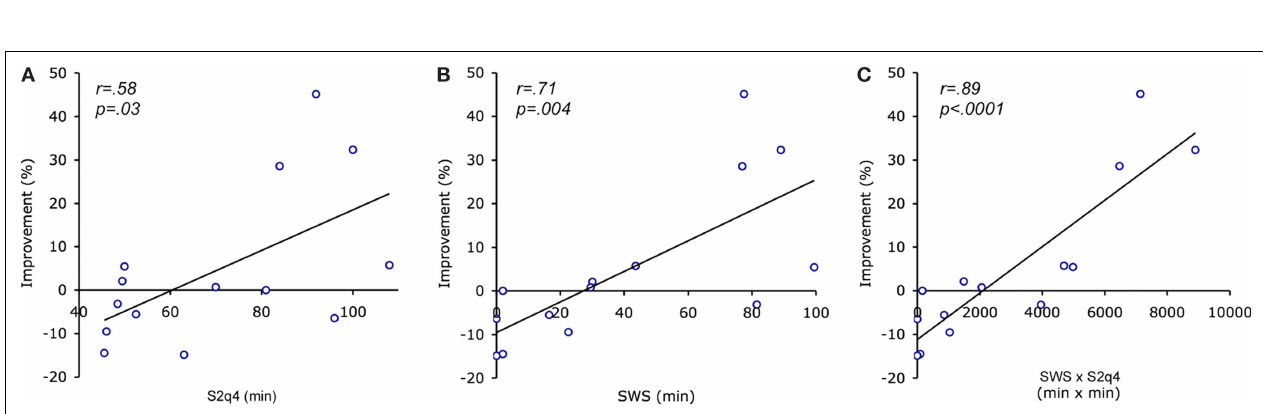
illustrate the qualitative similarity of learning curves on Day 1 and the failure of overnight improvement in the schizophrenia group only. The dashed line is positioned at the mean value of the last three training trials for both the control and patient groups. The shaded bar represents the passage of 24 h, including a night of sleep. Patients and controls did not differ in the amount of learning during training, but only controls showed signifi cant overnight improvement.